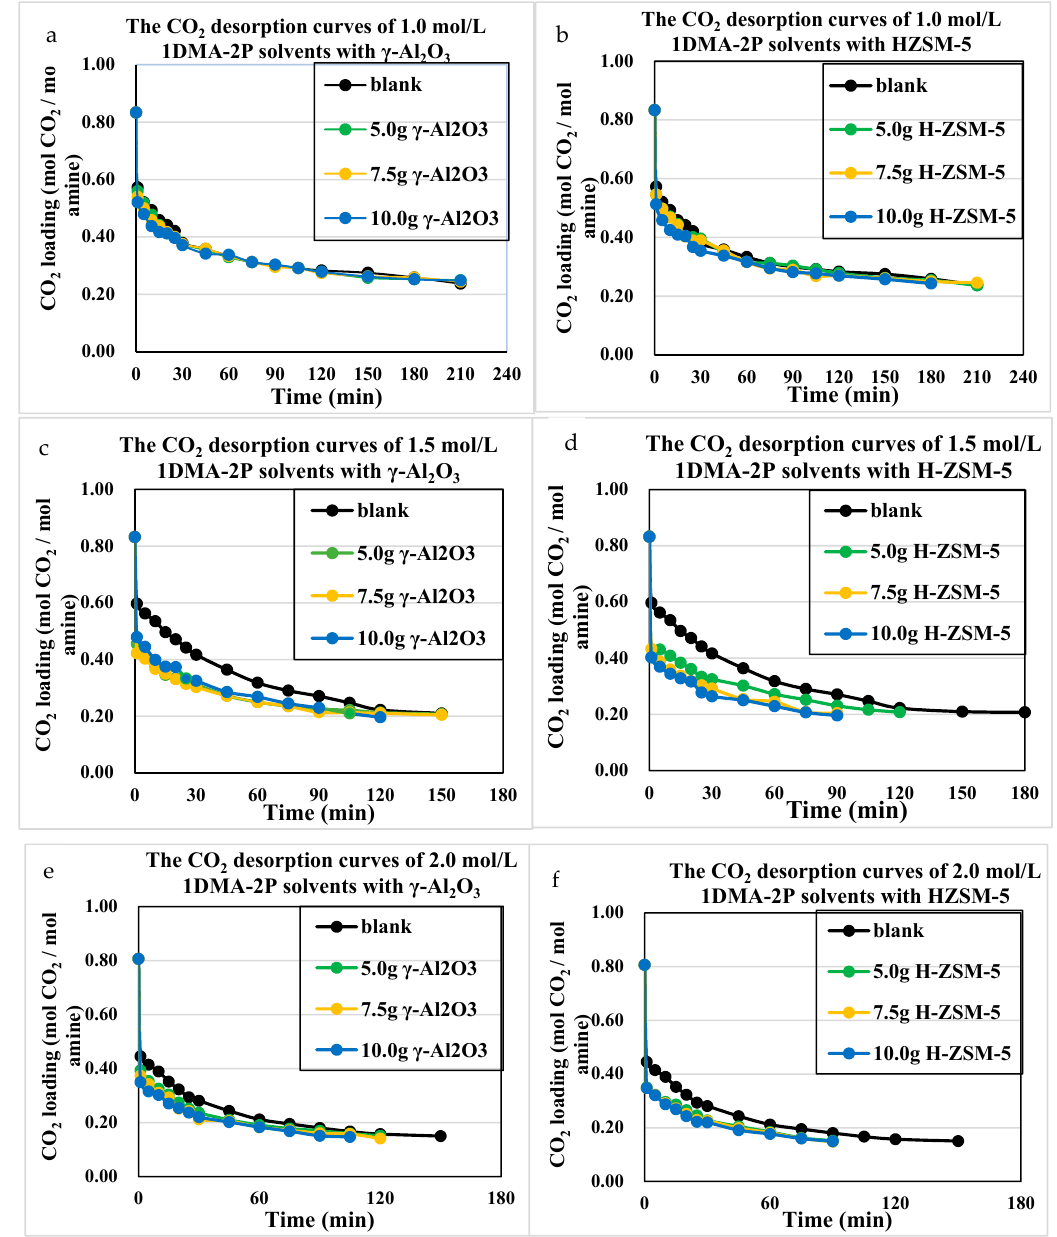
Figure 8. Catalytic CO 2 desorption curves of 1.0–2.0 mol/L DEEA solvents at 363 K and 1 atm, with 0– 10 g γ -Al 2 O 3 and H-ZSM-5. ( a , b ) 1.0 mol/L with γ -Al 2 O 3 and HZSM-5; ( c , d ) 1.5 mol/L with γ -Al 2 O 3 and HZSM-5; ( e , f ) 2.0 mol/L with γ -Al 2 O 3 and HZSM-5.